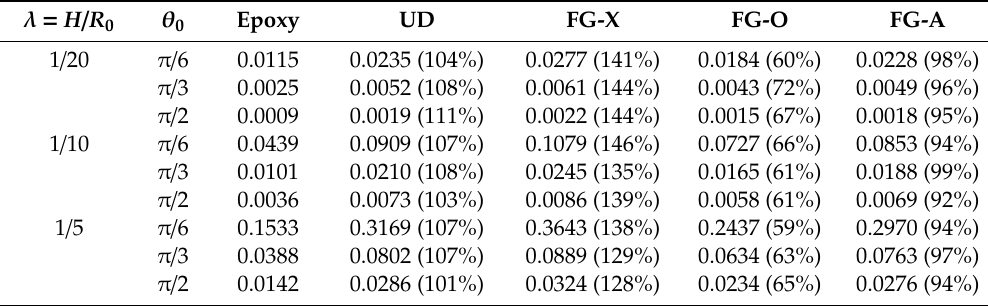
Table 6. The fundamental frequency Ω of C-F FG-GPLRC circular arch.